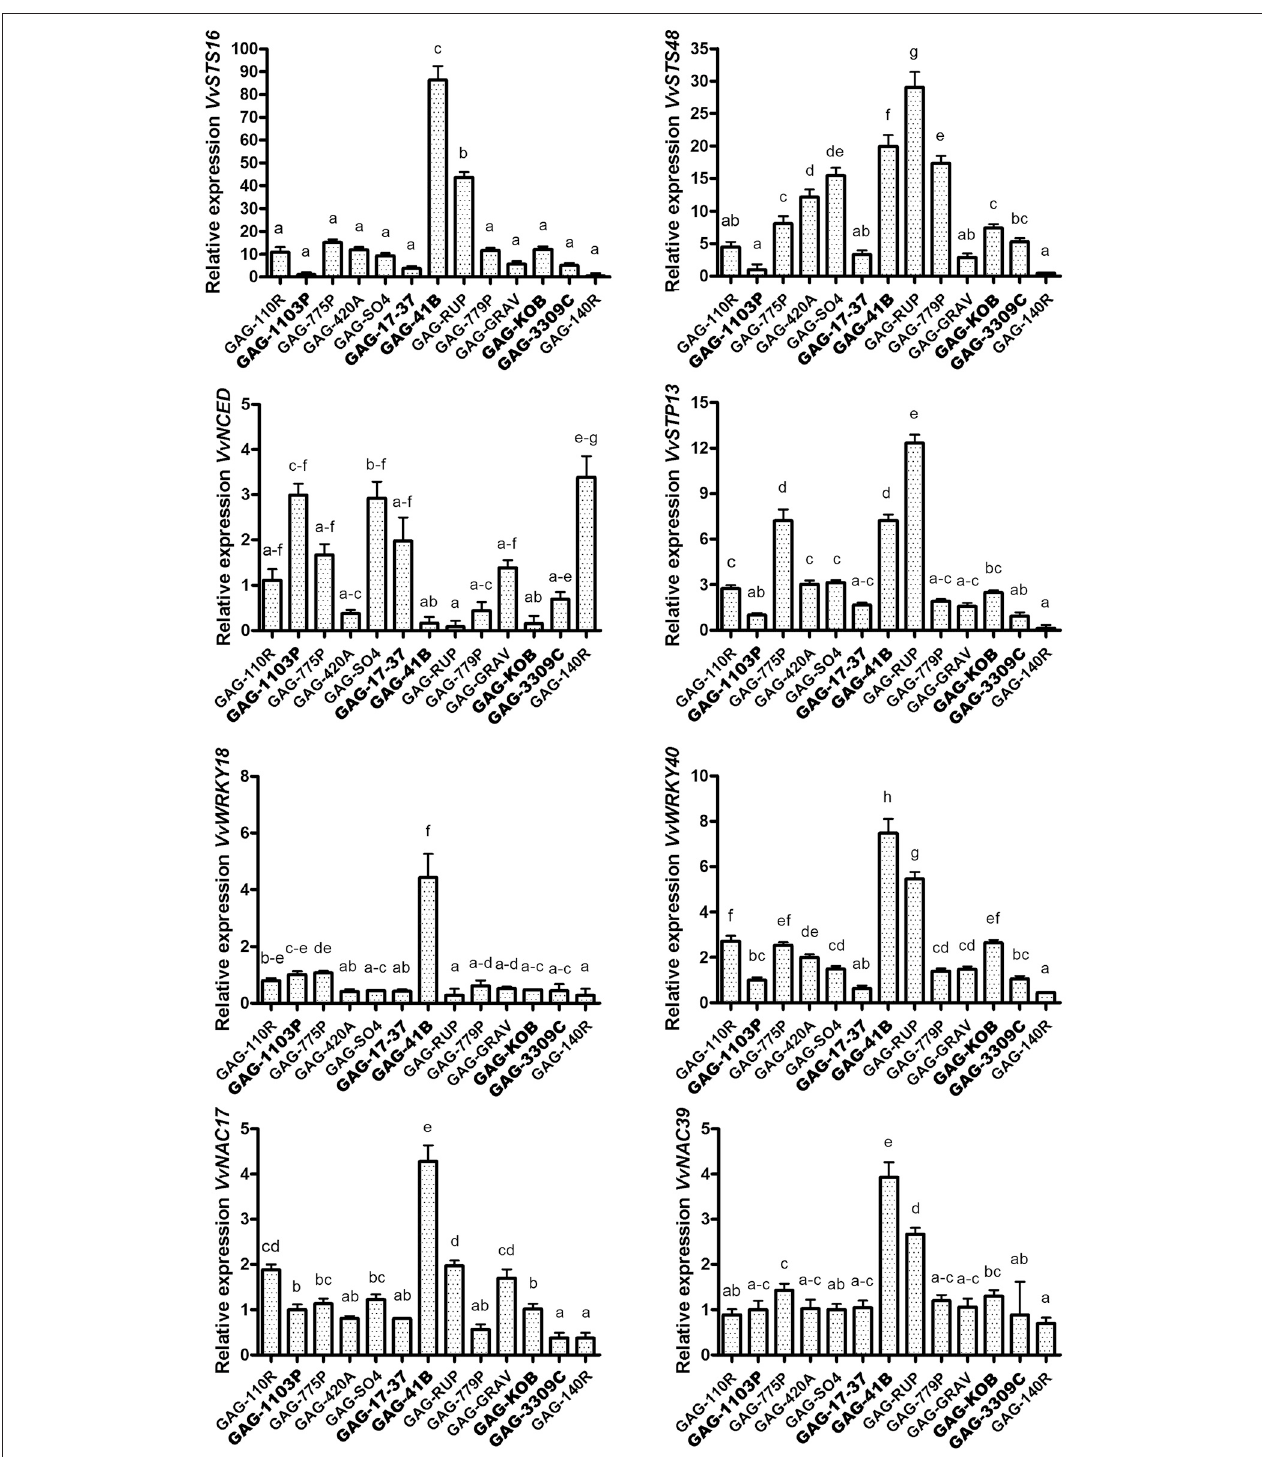
FIGURE 4 | Validation of the RNA sequencing results. Relative expression levels obtained by RT-qPCR analysis of the VvSTS16 (VIT_16s0100g00920), VvSTS48 (VIT_16s0100g01200), VvNCED (VIT_02s0087g00930), VvSTP13 (VIT_05s0020g03140), VvWRKY18 (VIT_04s0008g05760), VvWRKY40 (VIT_09s0018g00240), VvNAC17 (VIT_19s0014g03290) and VvNAC39 (VIT_07s0031g02610) genes tested in the 13 graft combinations. Lower case letters above bars denote significant differences by Tukey’s HSD-test ( P < 0.05). Data are expressed as mean ± SE ( n = 3). The combinations chosen for RNA-seq analyses are indicated in bold font.